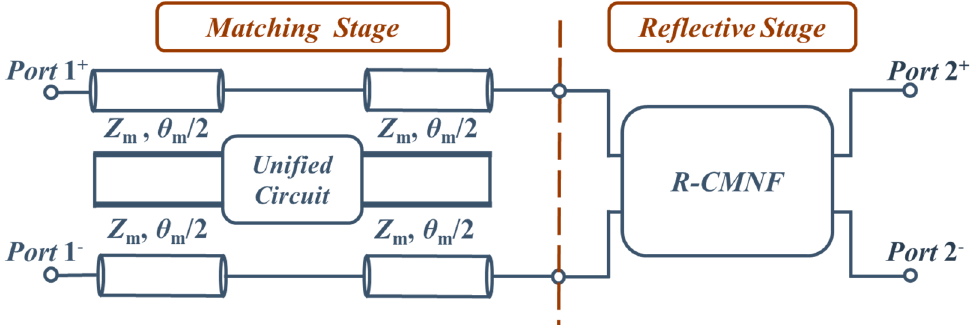
Figure 1. Schematic of the proposed structure.